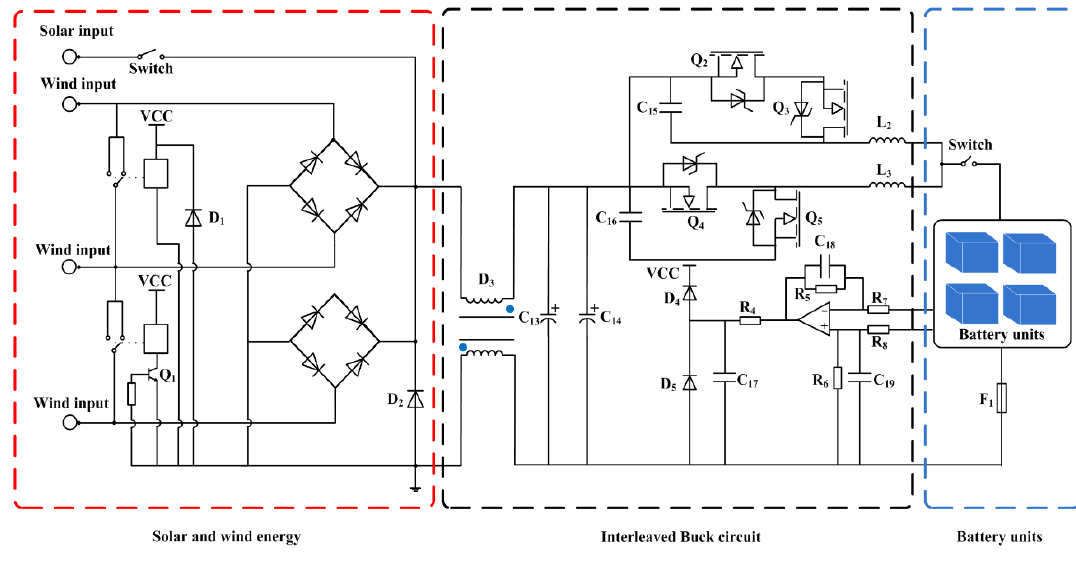
Figure 14. The solar/wind charging circuit.